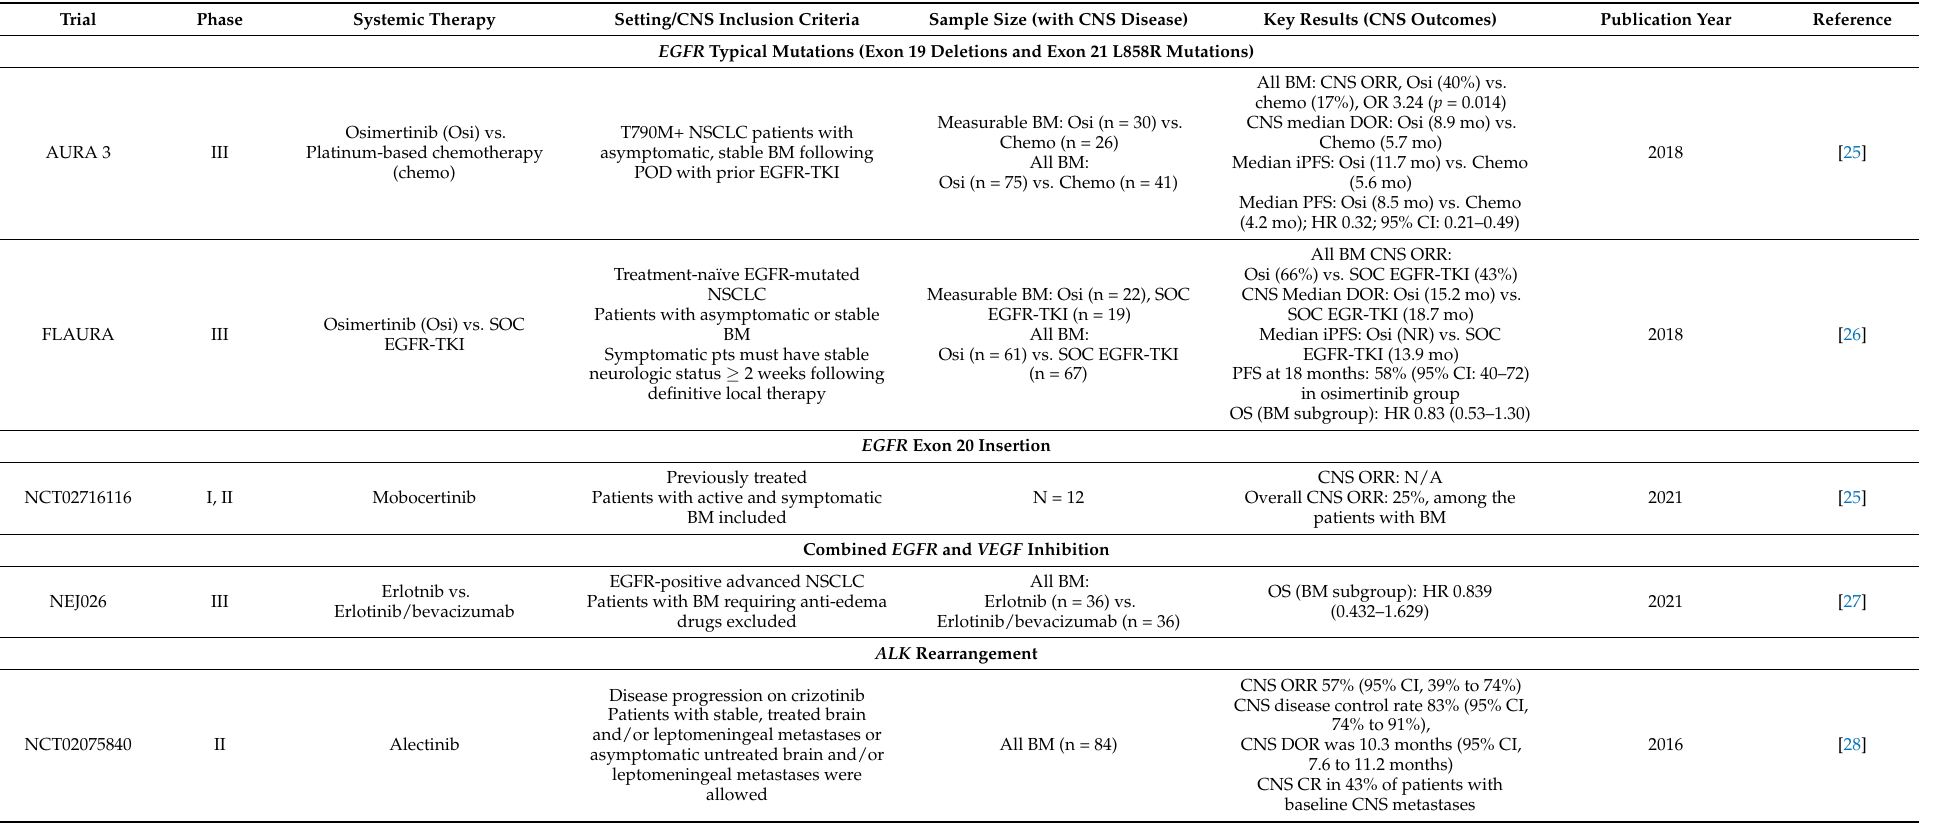
Table 1. Efficacy of Targeted Therapies in Non-small Cell Lung Cancer (NSCLC) with Central Nervous System (CNS)